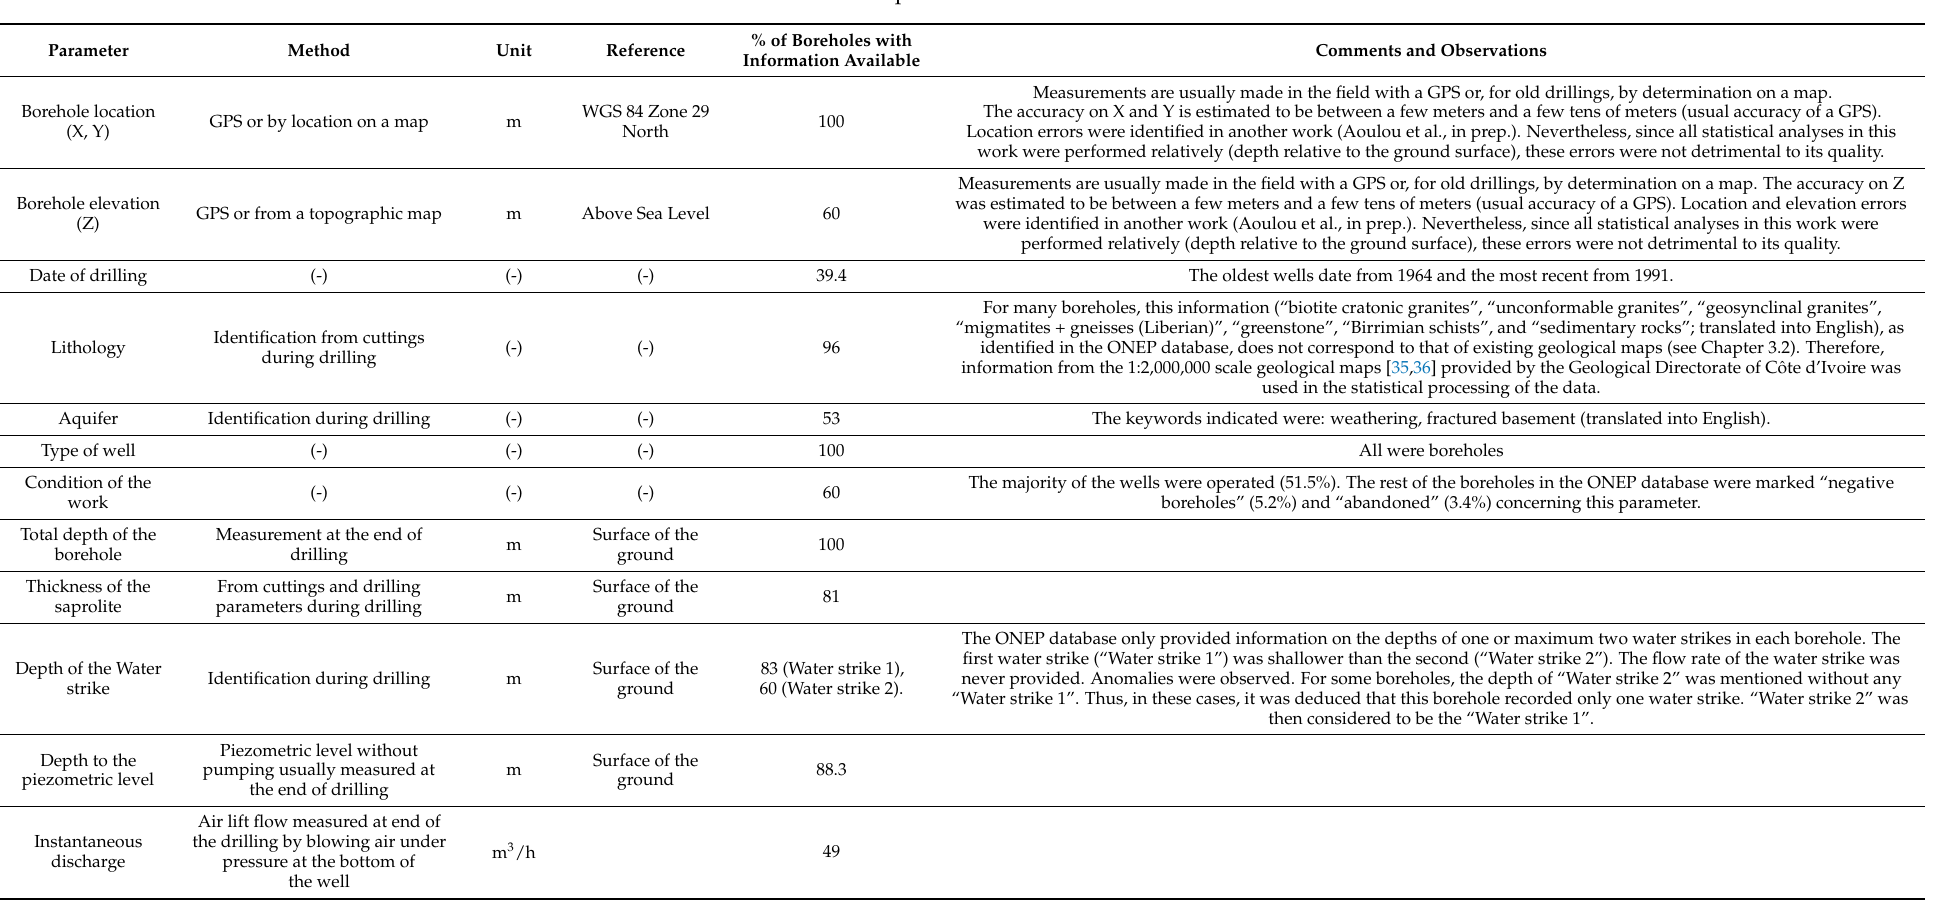
Table 1. Description of the ONEP